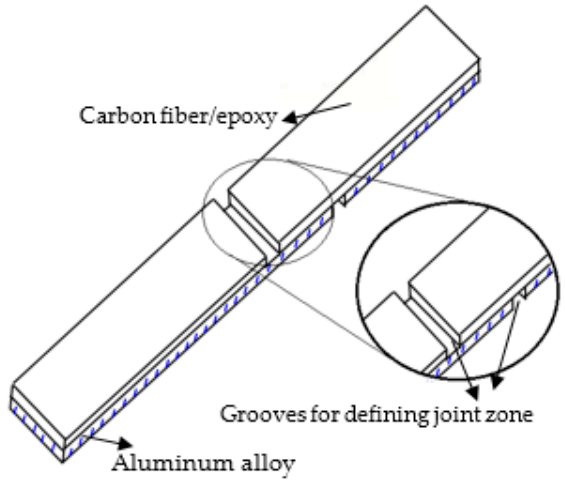
Figure 7. Schematic of the double notch test specimen [44].